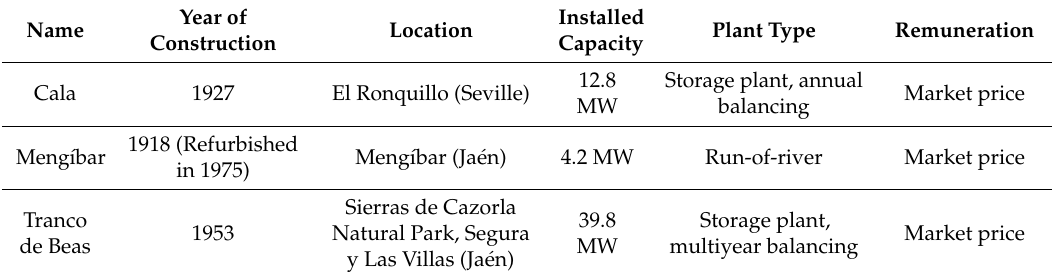
Table 1. Characteristics of the analyzed plants. Source: ENDESA.